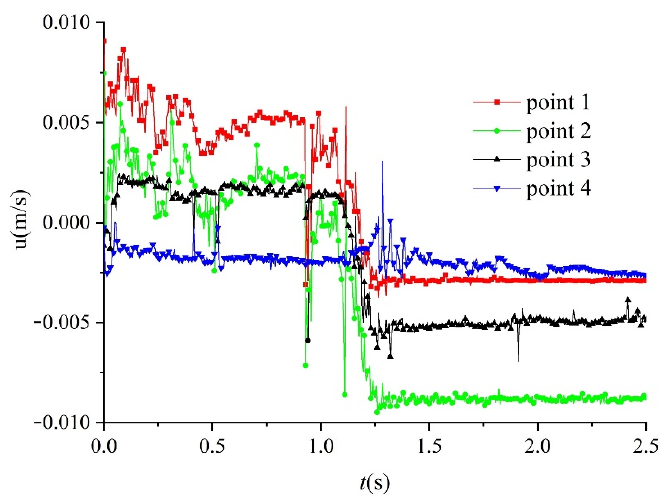
Figure 20. Velocity variation of different detection points with time.